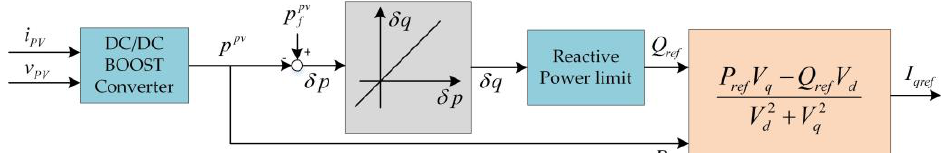
Figure 6. Reactive power (RP) control scheme [37].